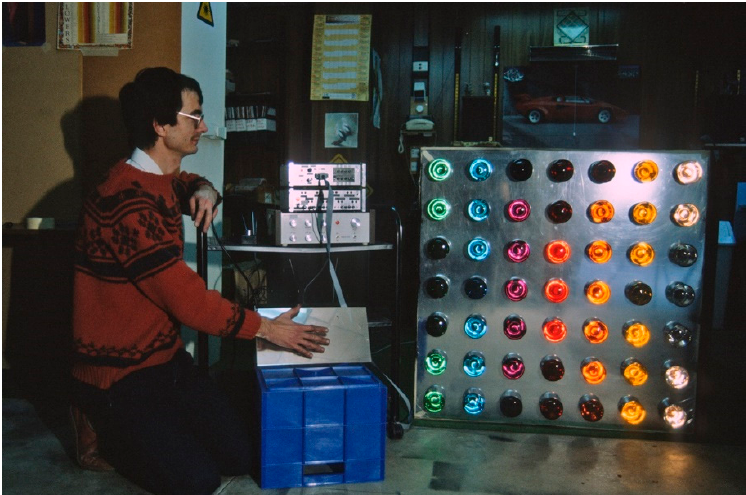
Figure 11. Russell Dahms with Ostoja’s theremin. Published with permission. Image courtesy Russell Dahms. Arts 2019 , 8 , x FOR PEER REVIEW